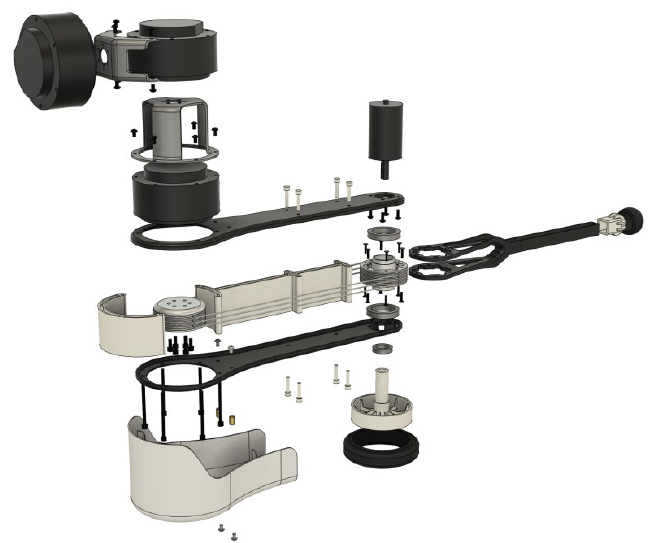
Figure 6. Exploded view of the structure of each robot leg.